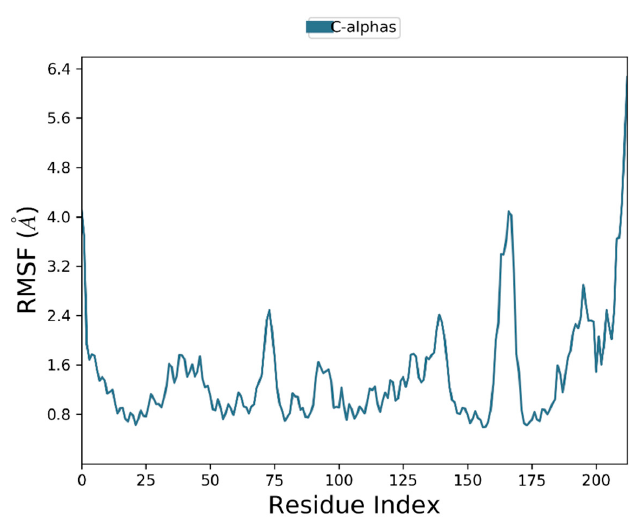
Figure 10 . Root mean square fluctuation of MAGE-A . Figure 10. Root mean square fluctuation of